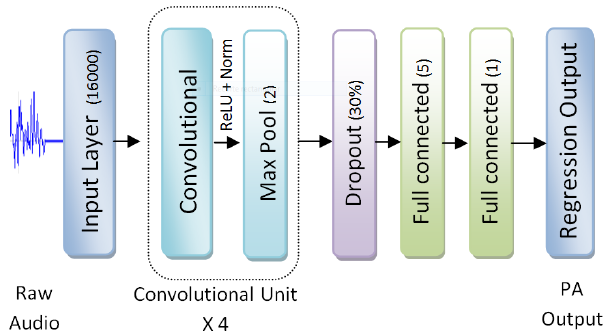
Figure 2. Regression CNN